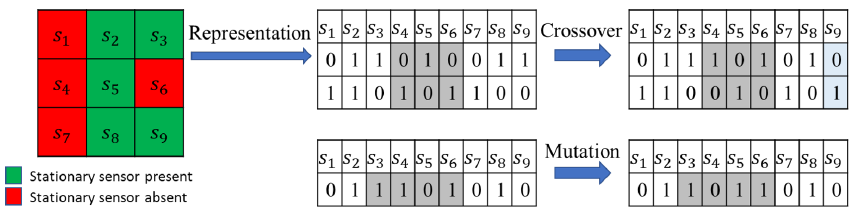
Figure 2. An example of representation, crossover and mutation in the genetic algorithm.